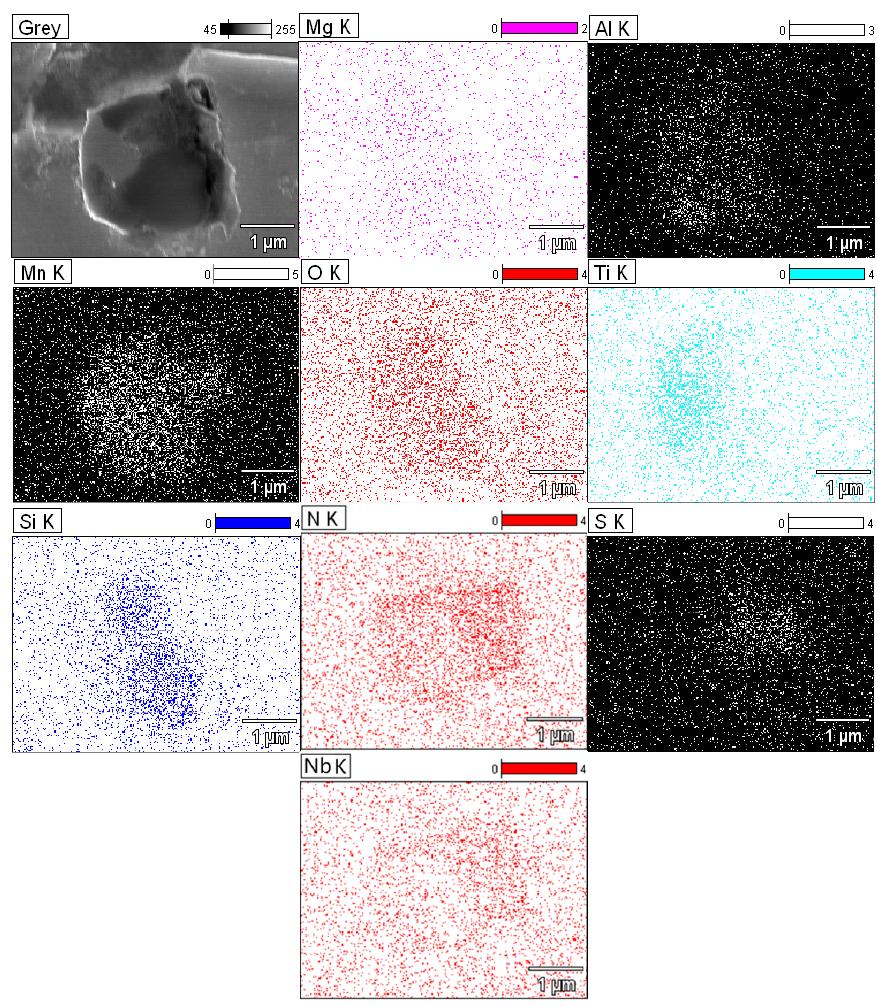
Figure 9. Mapping images of typical inclusions in testing steel with the Al–Mg–Ti microalloy addition sequence .